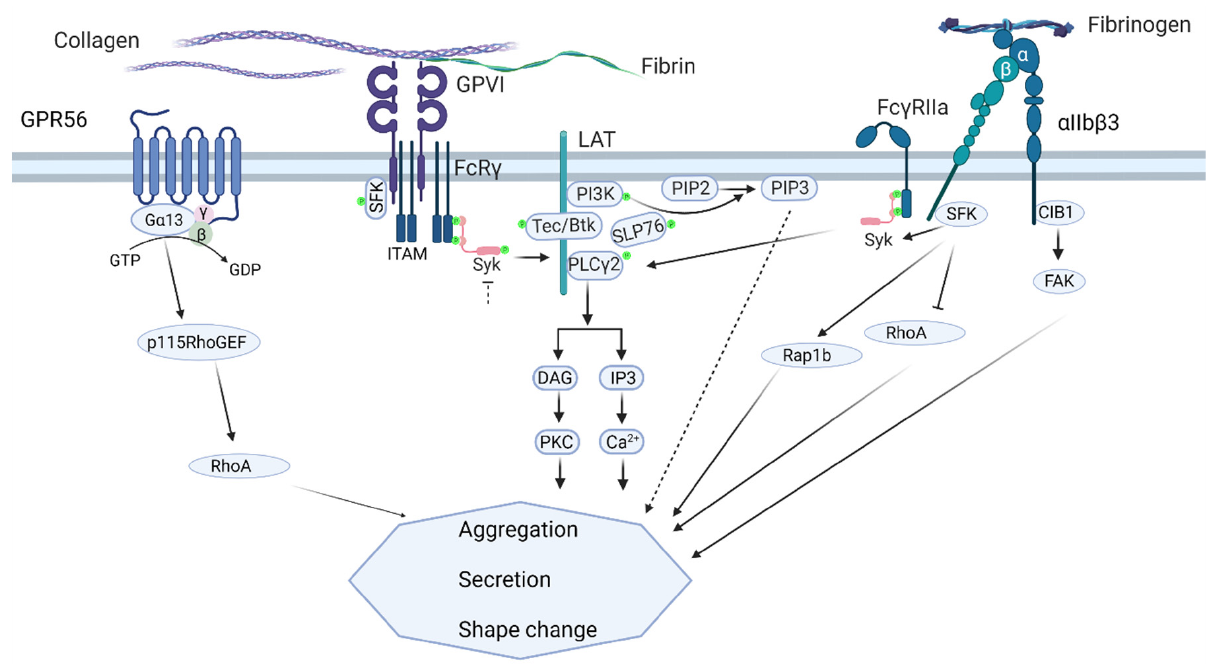
Figure 9. Scheme of the proposed combined action of GPR56, GPVI, and aIIbb3 signaling in shear- dependent thrombus formation on collagen, consisting of platelet aggregation, secretion, and shape change. (i) GPR56 signaling: small GTP-binding protein RhoA, activated by p115 RhoGEF (guanine nucleotide exchange factor). (ii) GPVI signaling via FcR γ -chain co-receptor: SFK (Src-family kinases) and the tyrosine kinases Syk, Tec, and Btk; phosphatidylinositol 3-kinase (PI3K); leading to activation of PLC γ 2, which generates the secondary messengers DAG (diacylglycerol) and IP 3 (inositol trisphosphate). (iii) α IIb β 3 outside-in signaling: SFK- and CIB1-mediated activation, the latter triggering PTK2 (focal adhesion kinase FAK); small GTP-binding proteins Rap1b and RhoA transmit parts of the signal. For further explanation, see text.